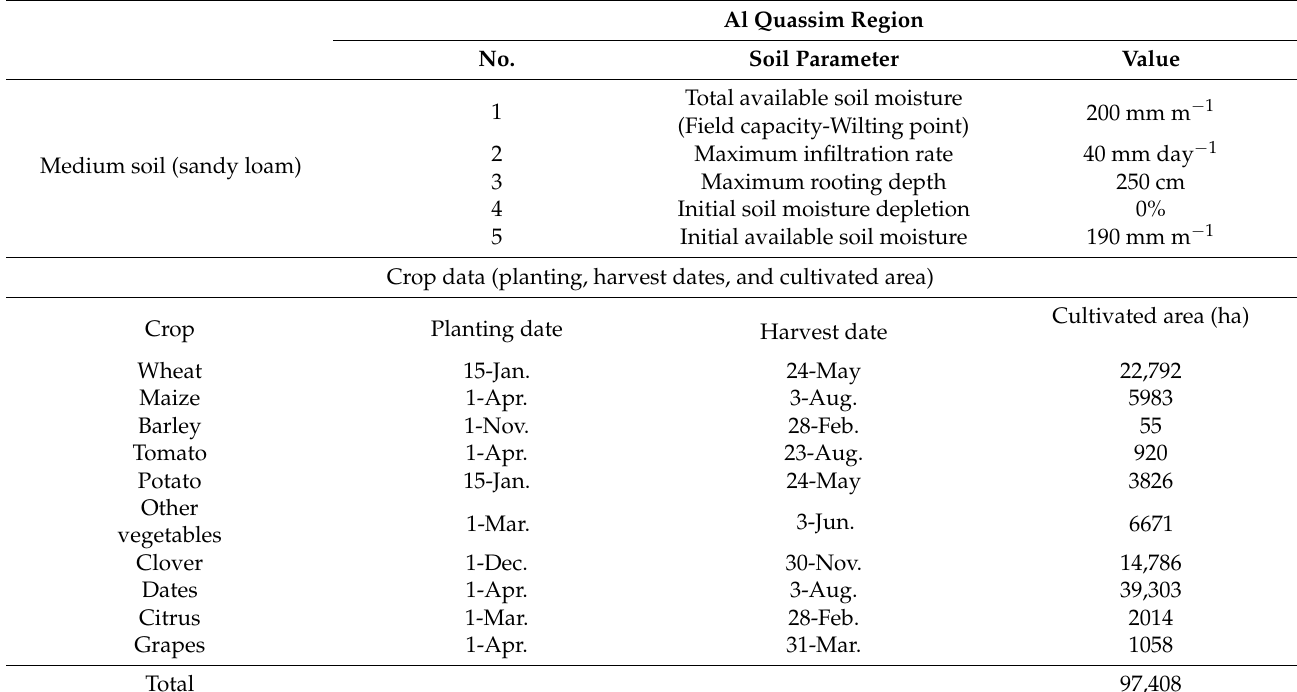
Table 3. Soil parameters and crop planting and harvesting dates for the Al Quassim